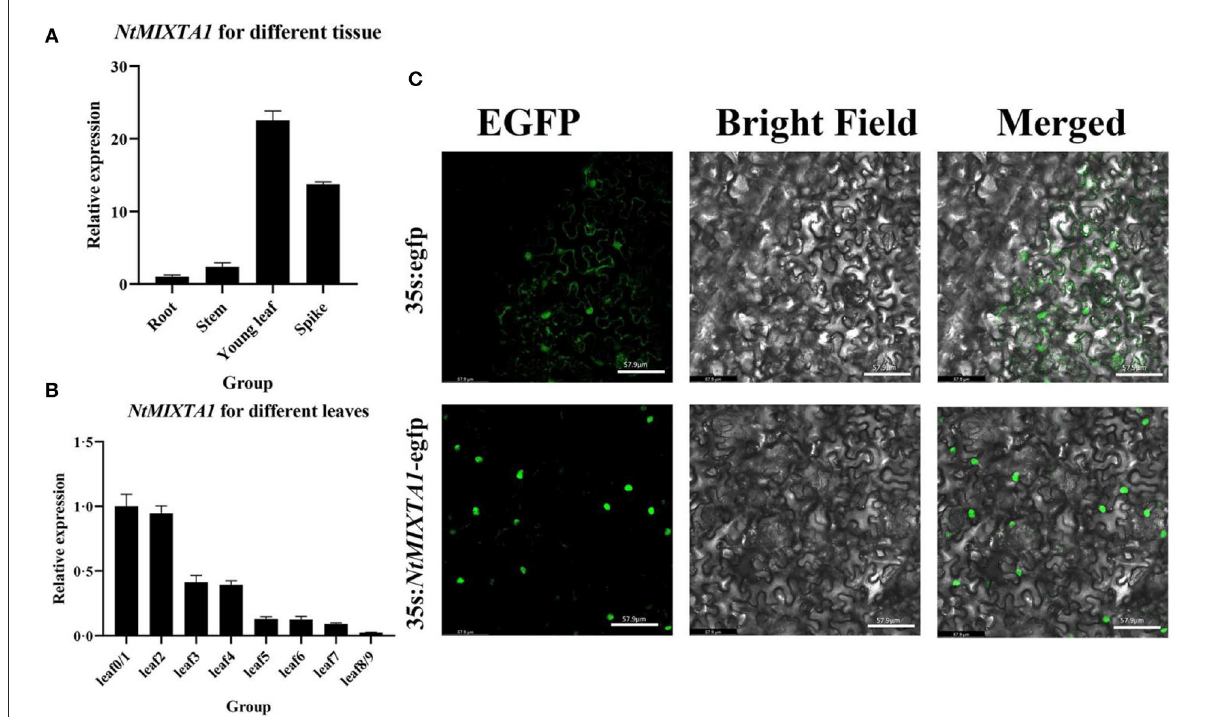
FIGURE2 Relative expression of NtMIXTA1 in different tissues (A) and leaves at different developmental stages (B) with β -actin as a reference gene. The relative expression levels were represented as mean ± SD ( n = 3). (C) Subcellular localization of the StMIXTA protein in Nicotiana benthamiana epidermal cells. Bars = 57.9 µ